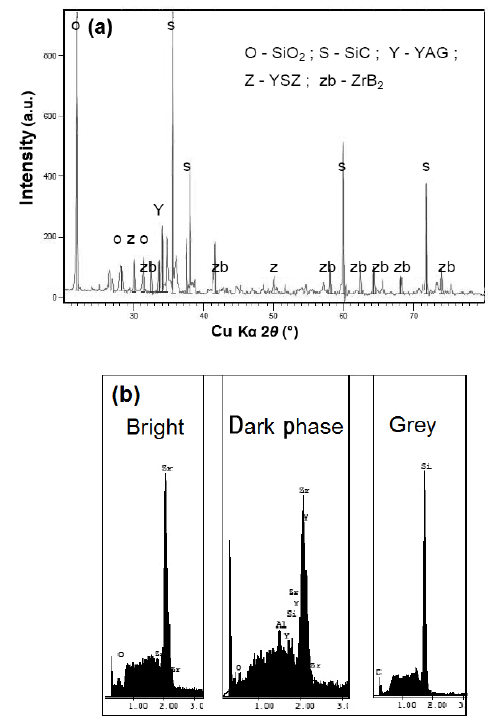
Fig. 8 (a) XRD pattern of oxide layer and (b) EDS of parent composite of PLRS 2.0 after 10 min exposure to plasma flame at 2700 ℃